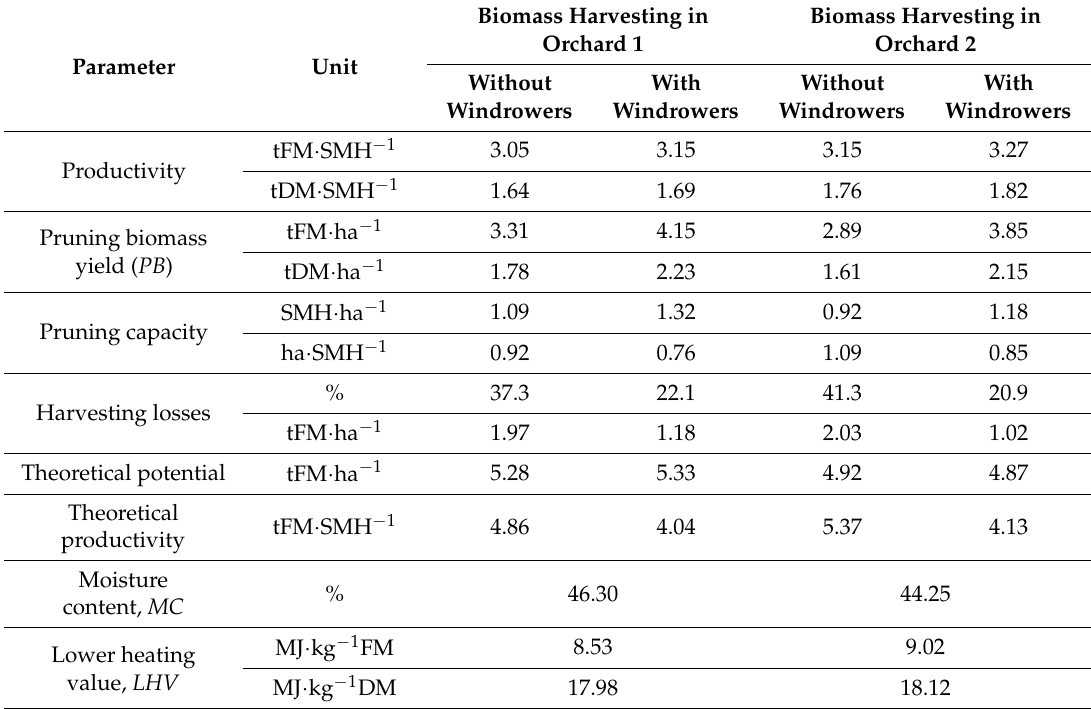
Table 2. Main data of the machinery performance and biomass